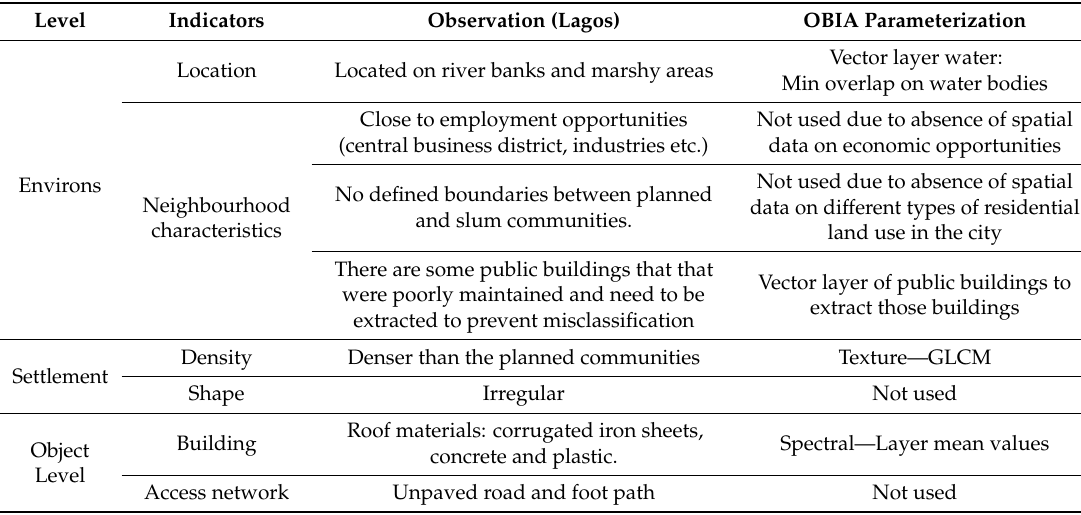
Table 2. Adaptation of generic slum ontology concepts to an ontology for Lagos, with OBIA parameterization at environs, settlement, and objects.